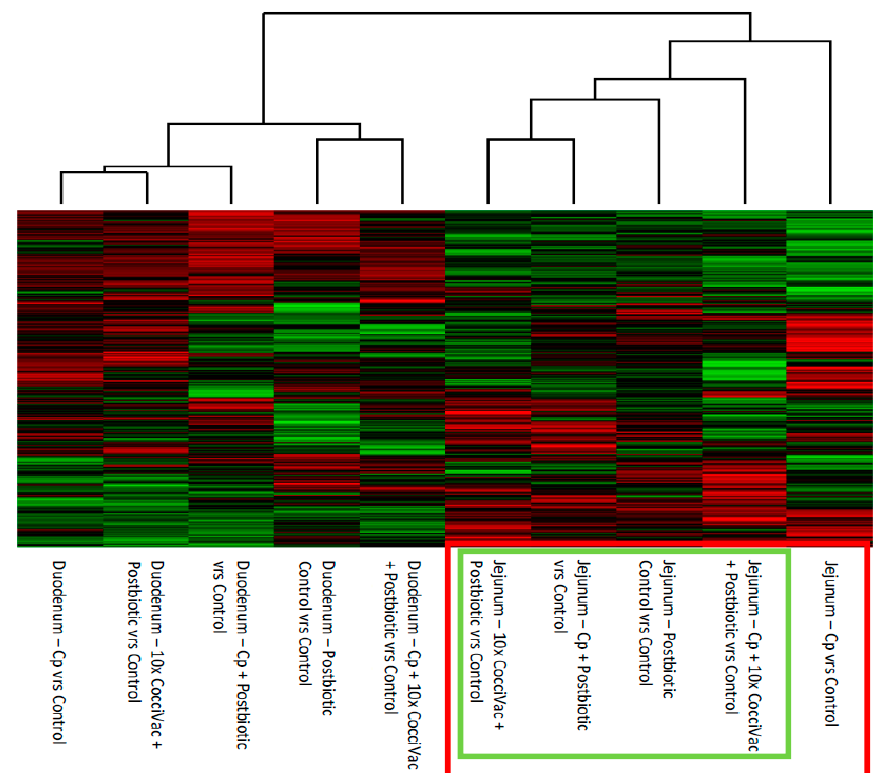
Figure 2. Heatmap and Clustering of Treatment Kinome Profiles Relative to Control Kinome Profiles. The raw kinome signal from the peptide array was input into the custom software package PIIKA 2. PIIKA 2 combines the biological replicates for each treatment and tissue, normalizes the data, and generates a representative kinome profile. Here, the profiles for each treatment group are compared to the kinome profile of control groups. The resulting kinome profiles are then compared for relative similarity, and a heatmap shows the relative phosphorylation of each peptide on the array for a given treatment group relative to control. Cp = C. perfringens .